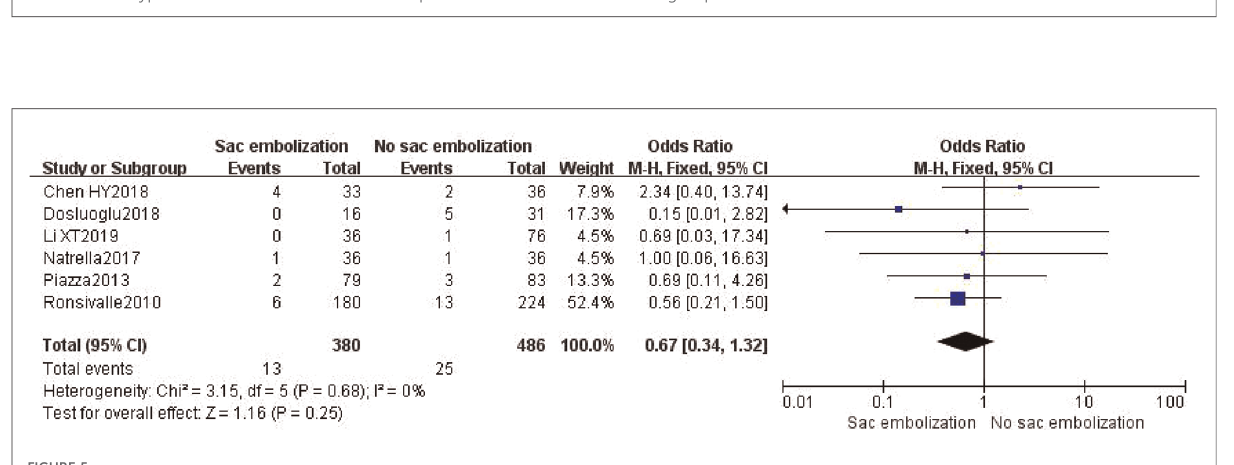
FIGURE 4 Incidence of type II endoleak at the last follow-up in different embolic material group.